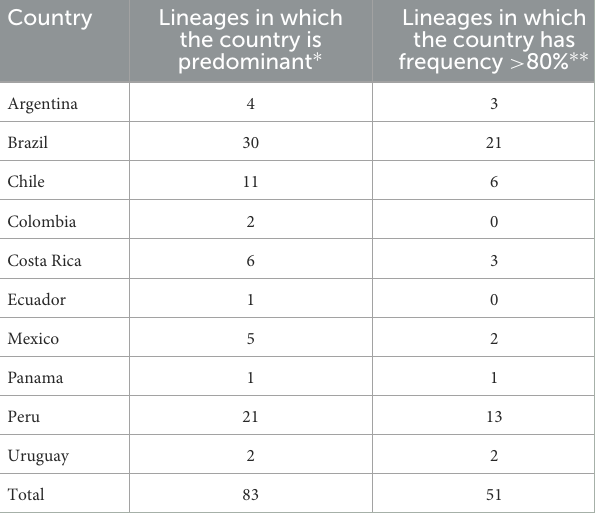
TABLE 3 Number of lineages in which a Latin American country is predominant by